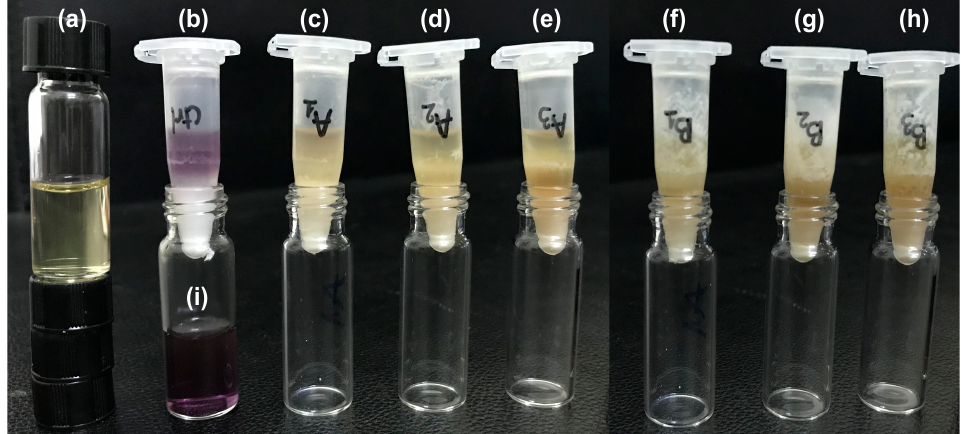
Figure 4. The color change of DPPH scavenging tests after incubation with Vitamin C solution of 1 mg/mL ( a ), GPT3.75 α -CD10.5 gel—a control sample ( b ), GPT3.75 α -CD10.5aqCT1.25 gel ( c ), GPT3.75 α -CD10.5aqCT2.5 gel ( d ), GPT3.75 α -CD10.5aqCT5 gel ( e ), GPT3.75 α -CD15aqCT3.75 gel ( f ), GPT3.75 α -CD15aqCT5 gel ( g ), GPT3.75 α -CD15aqCT6.25 gel ( h ), and DIW ( i ).